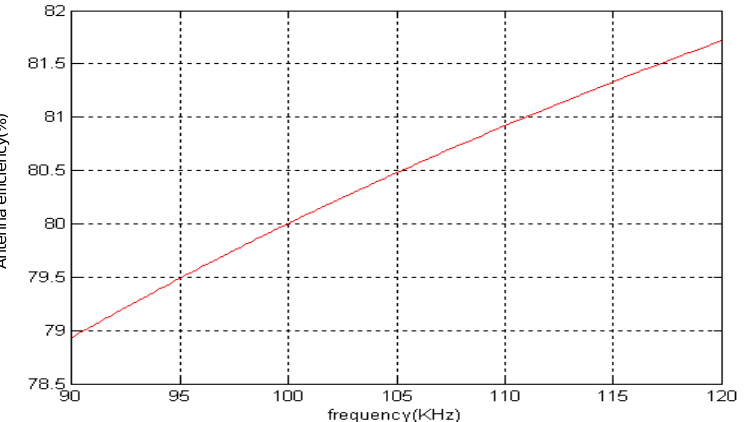
Figure 9. Antenna magnetic field distribution (quarter area).